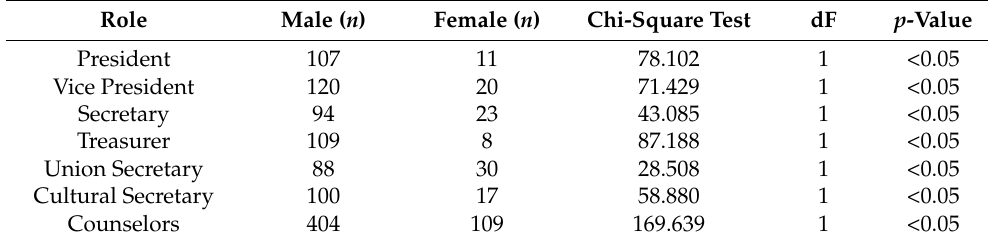
Table 5. Roles in the ANDI boards. Chi-square tests, dF (degree of freedom) values, and p -values.